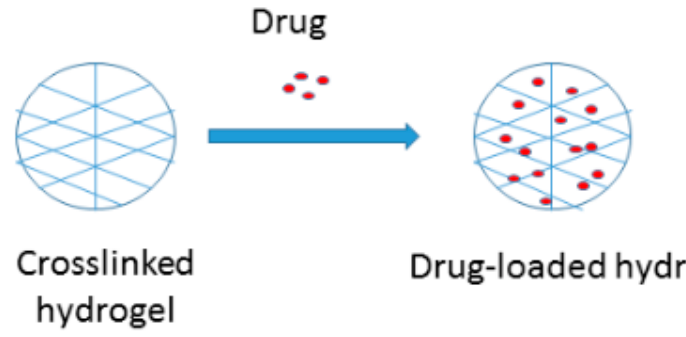
Figure 4. Schematic diagram of hydrogels.